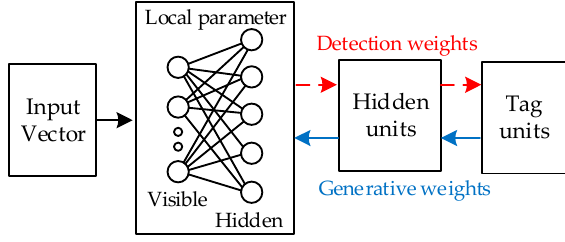
Figure 3. Illustration of the restricted Boltzmann machine framework.